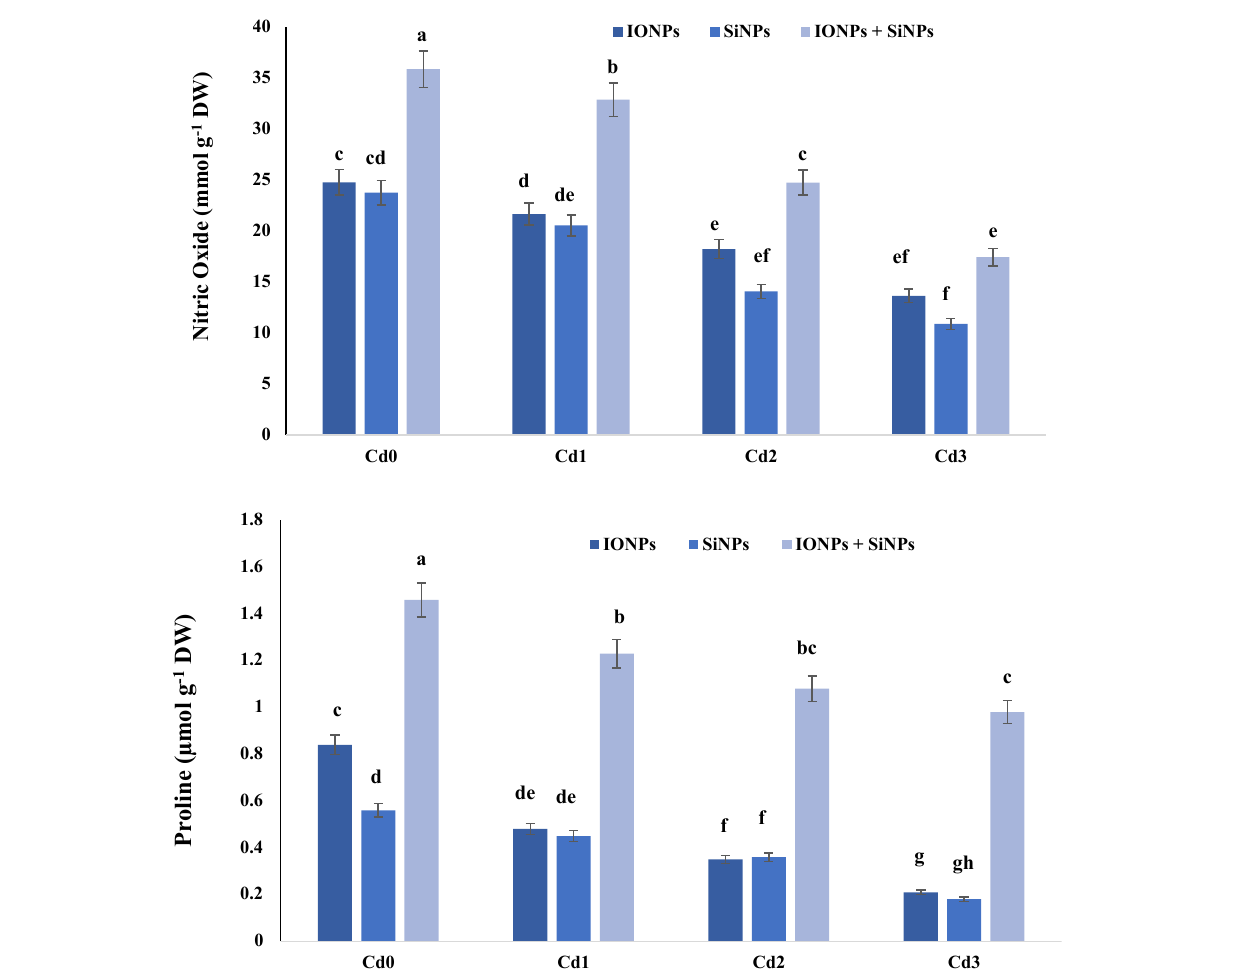
FIGURE 4 | Effect of IONPs and SiNPs on nitric oxide and proline content of Phaseolus vulgaris grown in different concentrations of Cd. Here IONPs, SiNPs, Cd0, Cd1, Cd2, and Cd3 indicate iron oxide nanoparticles, silicon nanoparticles, 0 mM CdCl 2 , 1 mM CdCl 2 , 1.5 mM CdCl 2 , and 2 mM CdCl 2 . Different letters indicate significant difference among the treatments ( P ≤